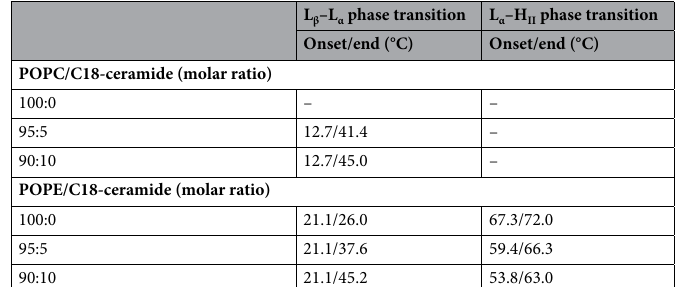
L β –L α phase transition L α –H II phase